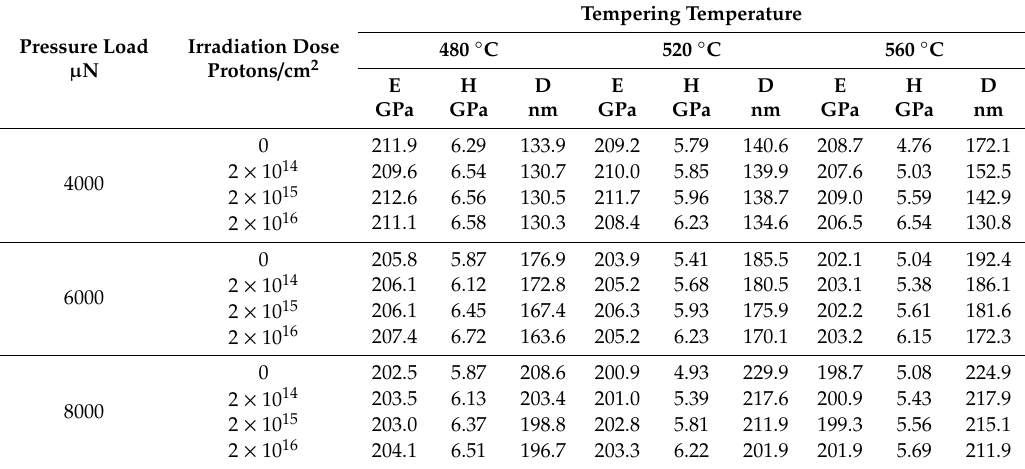
Table 2. Residual depth and nanoindentation hardness of tempered 5140 alloy steel before and after proton